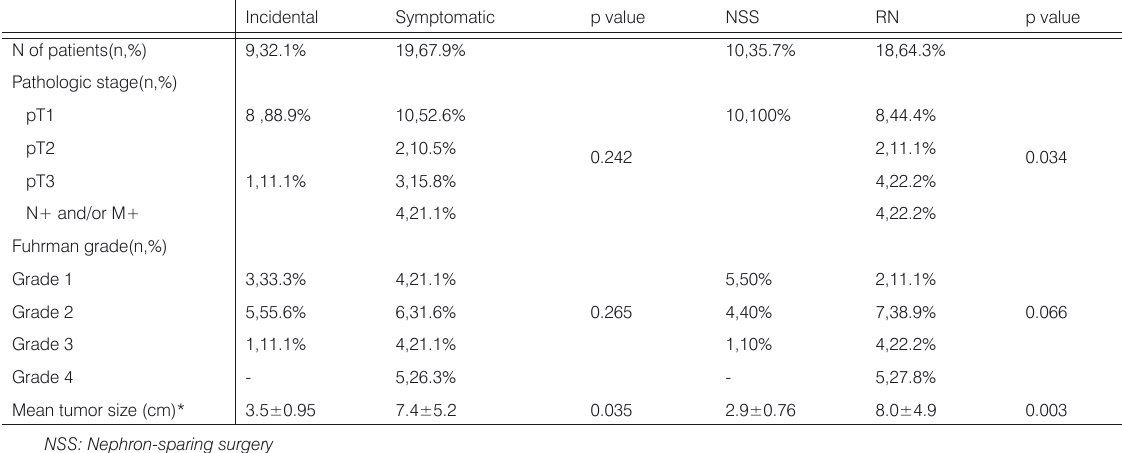
Table 2. Comparison of pathological features of tumors according to clinical presentation and type of